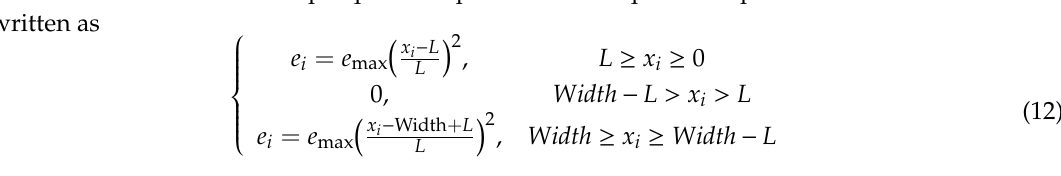
Figure 13. Schematic diagram of profile modification for helical gears.